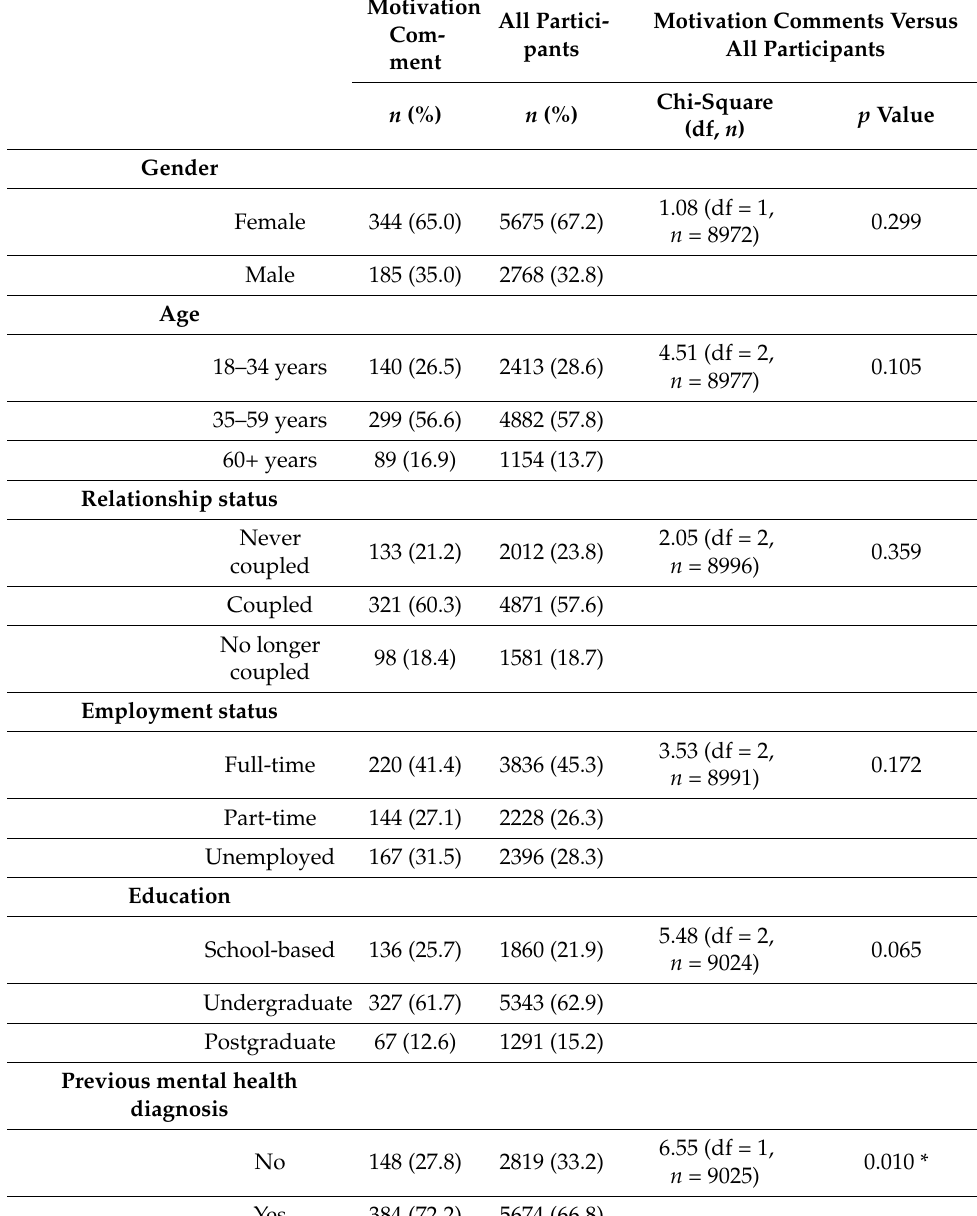
Table 1. Demographic and mental health characteristics of respondents who left a motivation comment compared with all